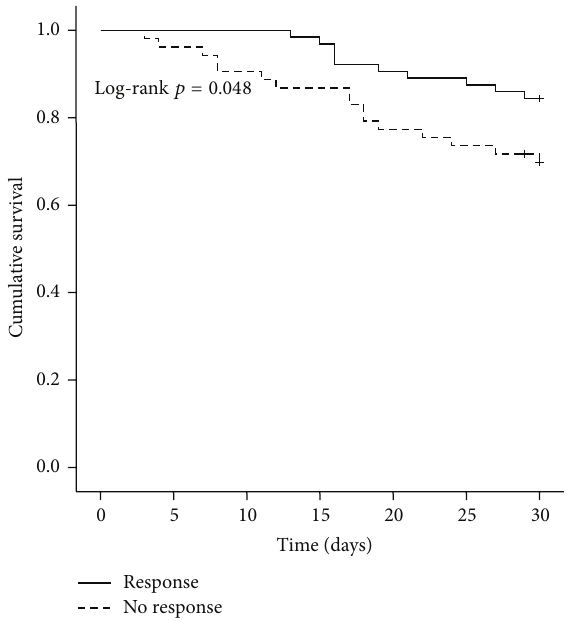
Figure1:Kaplan-Meiersurvivalanalysisofthepatientcohort:mean short-term survival was significantly longer in the responder group compared with nonresponders to terlipressin therapy: 28.4 days [95% CI 27.3–29.4] versus 25.6 days [95% CI 23.3–27.8] (responder versus nonresponder group, log-rank test, and 𝑝 = 0.048 ).